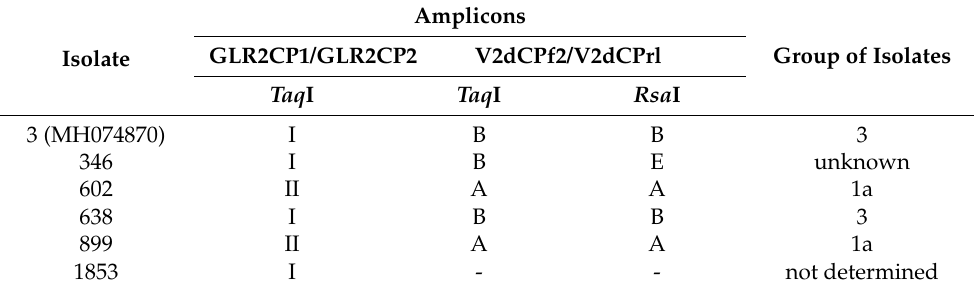
Table 1. RFLP profiles of different GLRaV-2